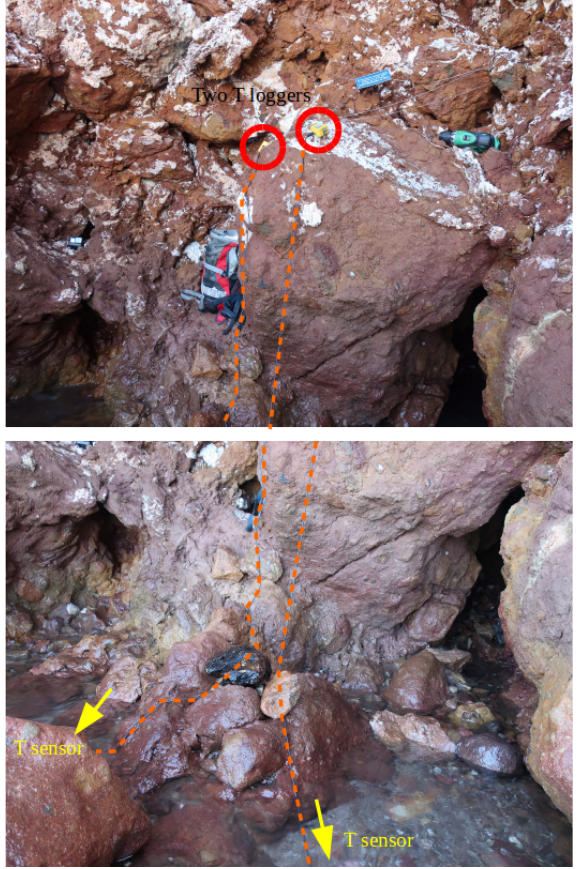
Figure 14. The hot spring opposite Green Island showing the attachment of two tinytag plus 2 data loggers to the cliff face and the cable path towards the submerged